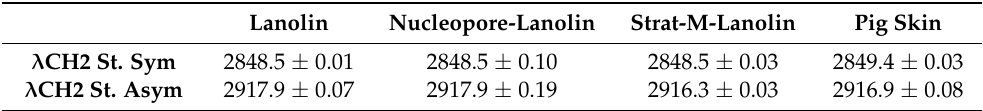
Table 2. ATR-FTIR of CH 2 symmetric and asymmetric stretching modes of pure lanolin, Nucleopore-lanolin, Strat-M-lanolin and pig skin. Lanolin Nucleopore-Lanolin Strat-M-Lanolin Pig Skin λ CH2 St. Sym